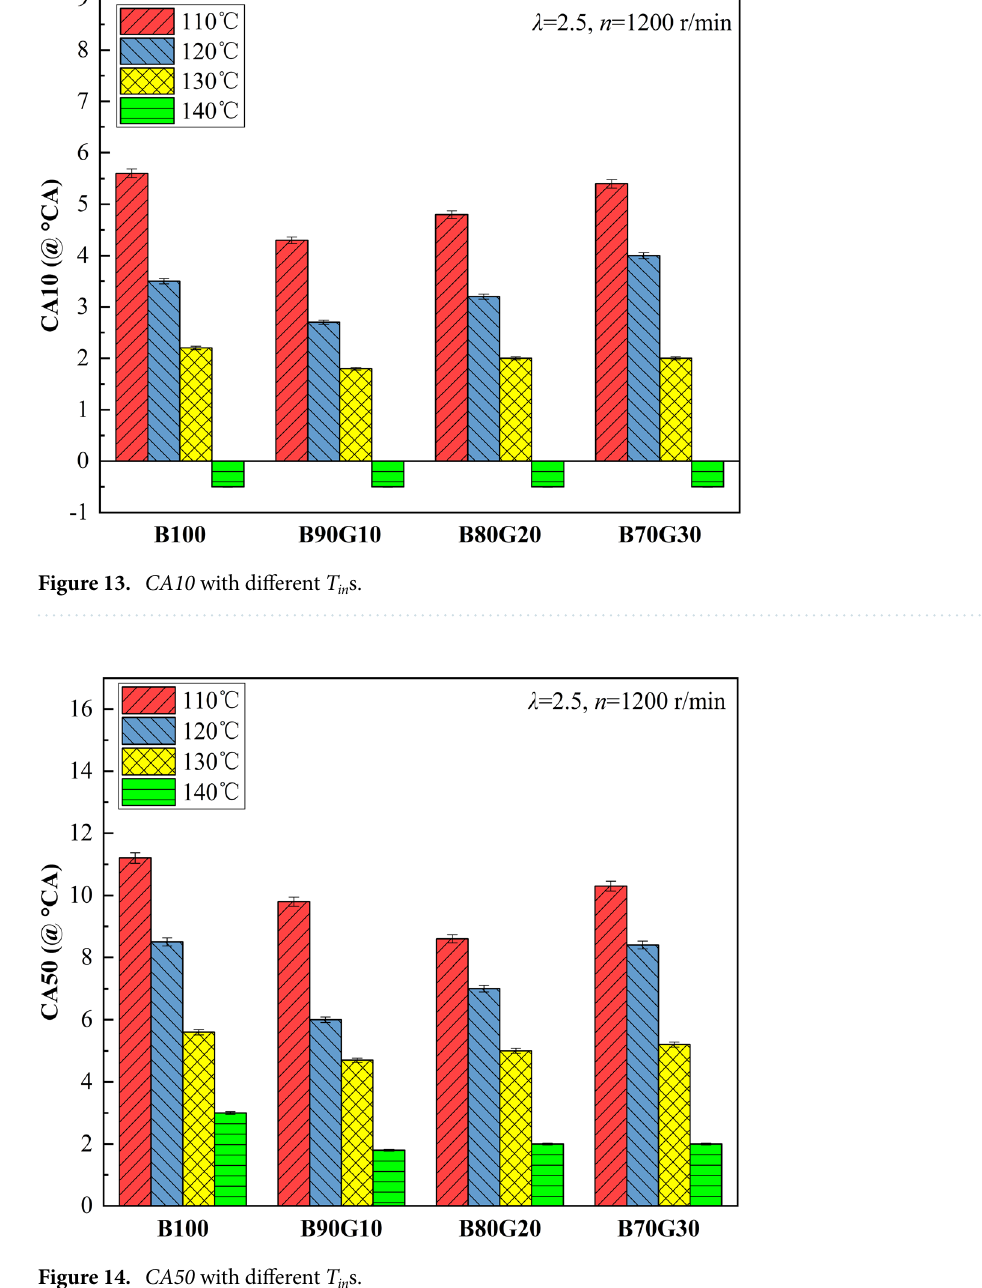
Figure 14. CA50 with different T in